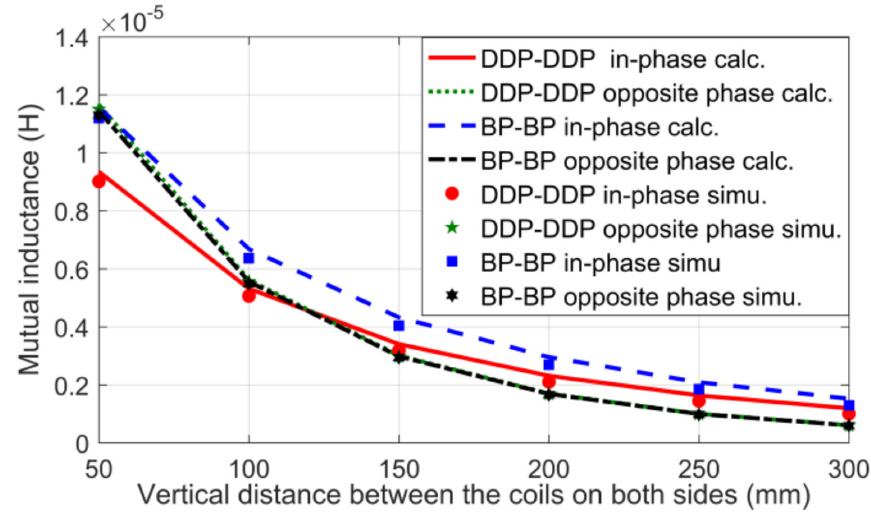
Figure 6. Mutual inductance of coils under misalignment along the z -axis and in different excitation